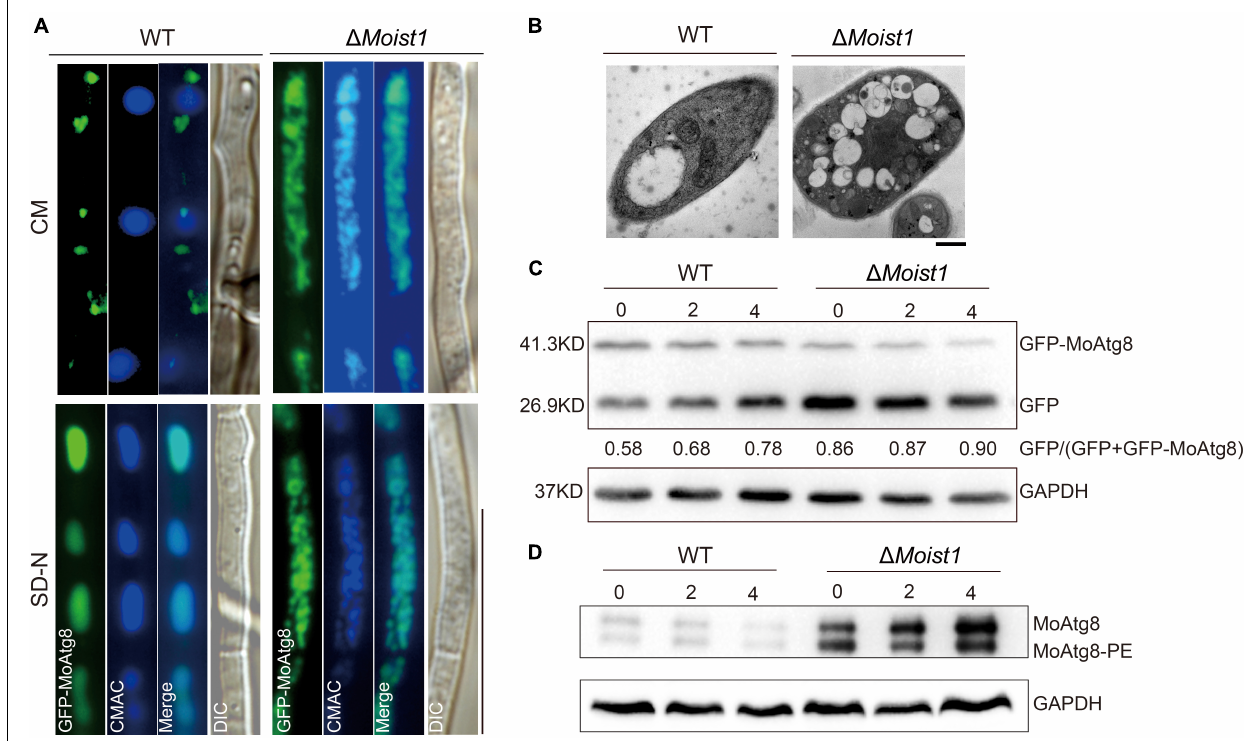
FIGURE 7 | MoIst1 is required for autophagy process. (A) Localization of GFP-MoAtg8 in WT and (cid:49) Moist1 . Strains were grown in liquid CM medium at 28 ◦ C for 48 h and then shifted to liquid SD-N medium for 4 h. Mycelia were stained with CMAC and examined under a fluorescence microscope. Bar = 50 µ m. (B) WT and (cid:49) Moist1 were cultured on solid CM for 7–9 days and then in CM liquid medium cultured at 28 ◦ C for 48 h continuously shaken at 138 rpm. Bar = 0.5 µ m. (C) Degradation of GFP-MoAtg8 was detected in WT and (cid:49) Moist1 under nitrogen starvation for 0, 2, and 4 h by GFP antibodies. GAPDH was used as an internal reference for protein standardization by Western blot. (D) The conversion of MoAtg8 to Lipidation of MoAtg8, MoAtg8-PE, was compared in WT and (cid:49) Moist1 with anti-Atg8 antibody. GAPDH was used as an internal reference for protein standardization by Western